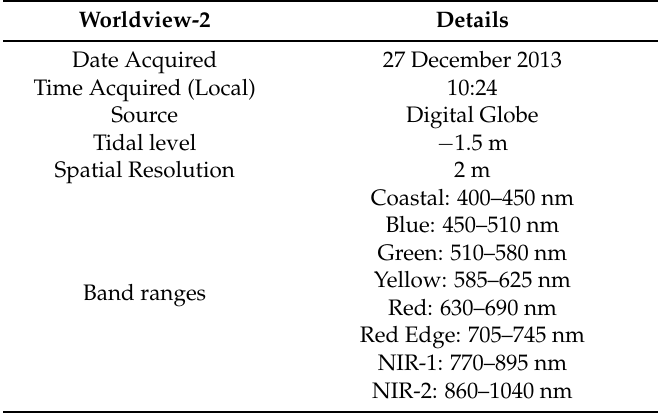
Table 1. Detailed information for Worldview-2 image data including the tidal level of the study area at acquisition